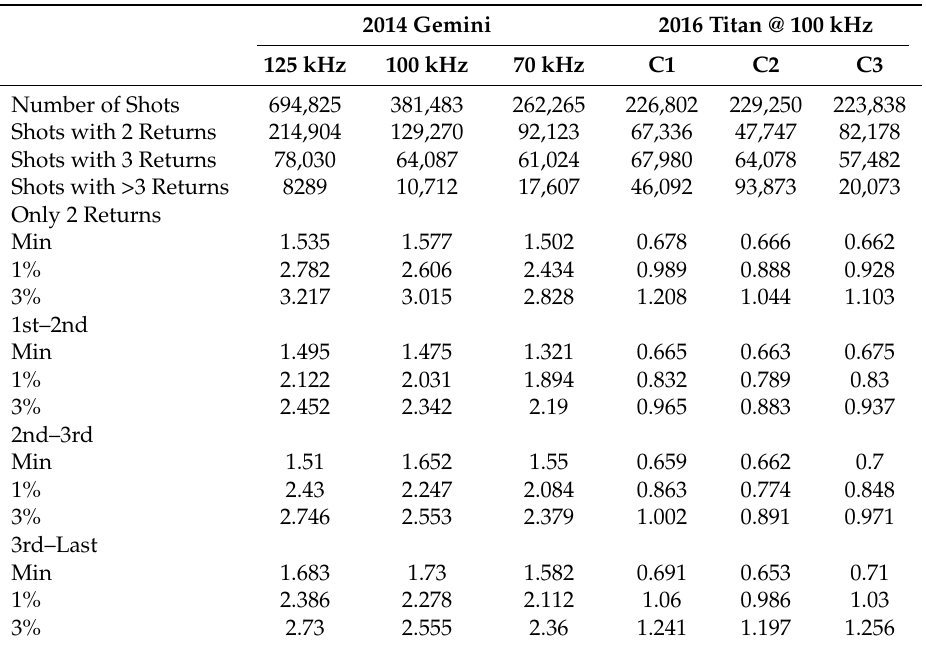
Table 7. Comparative results from minimum separation between returns test obtained from the Gemini and Titan lidar systems near the Calakmul Mayan site in Campeche, Mexico. Range separation results are given in